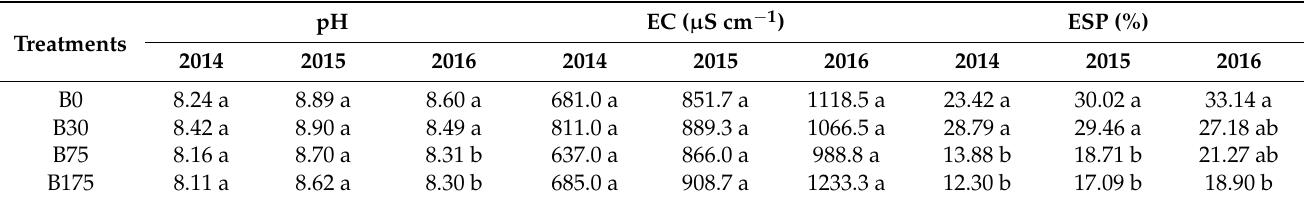
Table 2. Soil pH, electrical conductivity (EC), and exchangeable sodium percentage (ESP) in sulfate saline soils amended with biochar at various rates from 2014 to